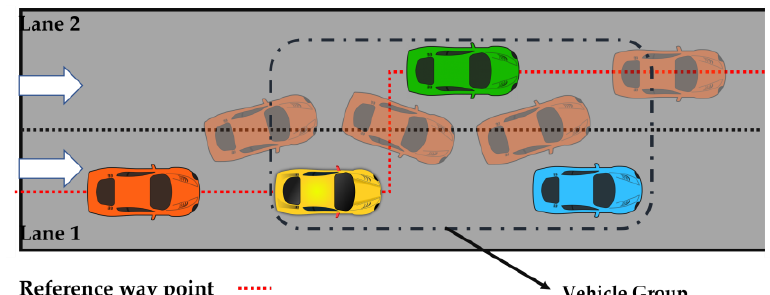
Figure 6. The sketch of the scenario in Experiment 3.